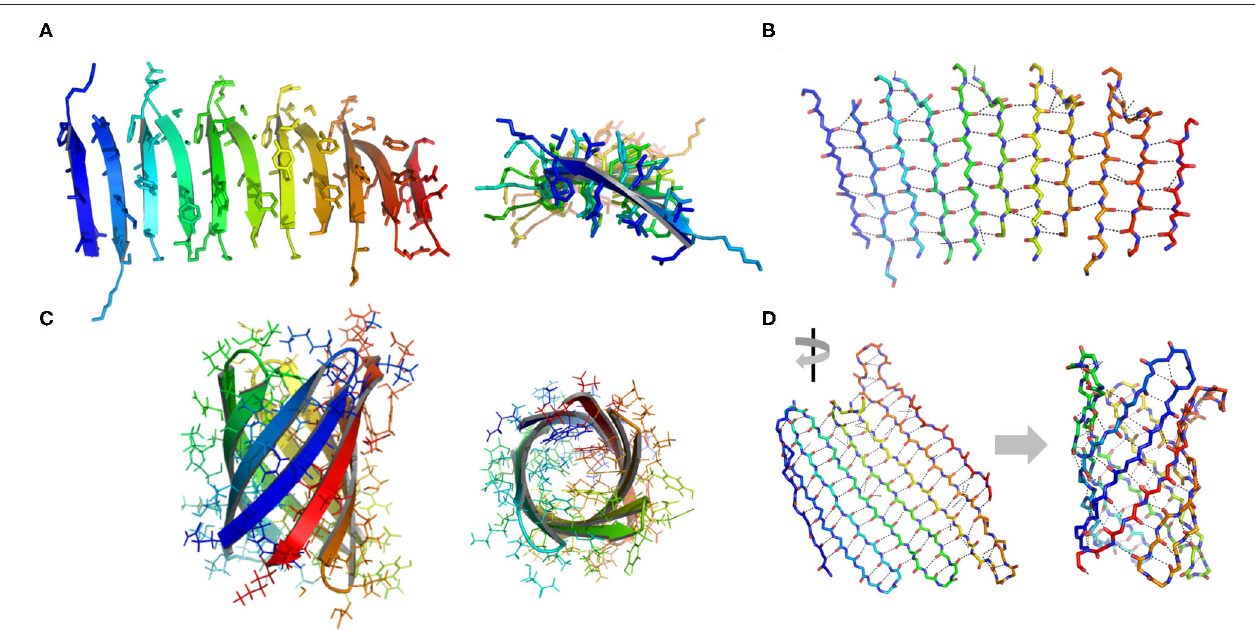
FIGURE 3 | Illustration of β structures. (A) A representative β -sheet structure (PDB ID 5YS7) viewed from perpendicular to the cross- β fibril (left) and along the growth direction of a cross- β fibril (right). (B) The hydrogen bond arrangement in a cross- β fibril. (C) A representative β -barrel structure (PDB ID 1JMX). Left: side view. Right: top view. (D) A 2D extended β sheet (left) rolls up to form a 3D β barrel (right). Hydrogen bonds are indicated by dash